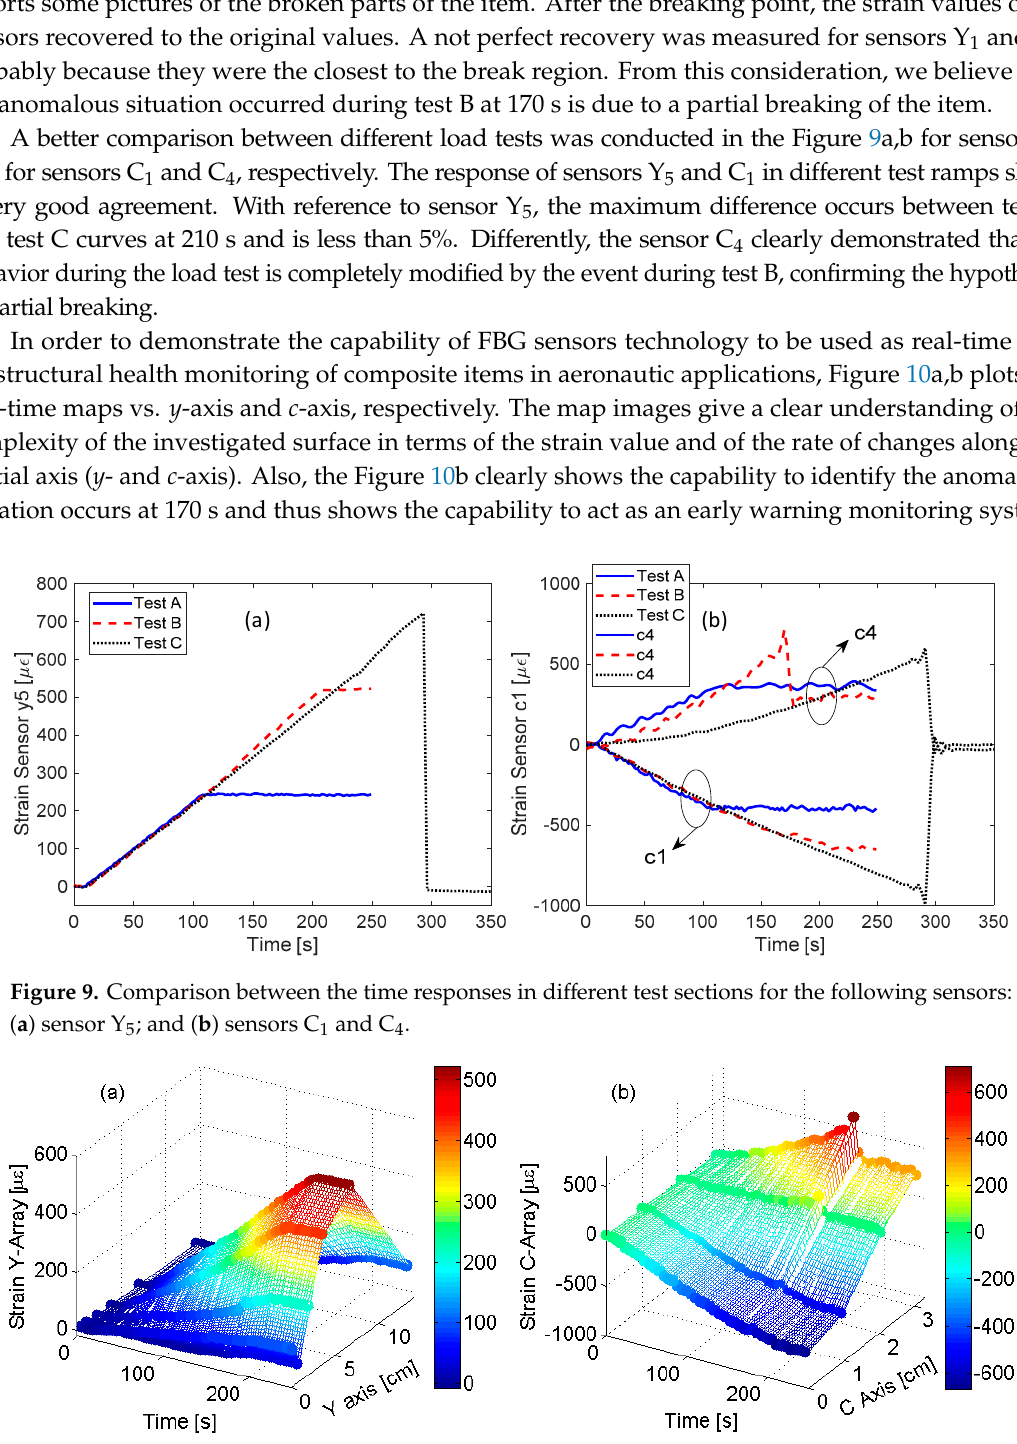
Figure 10. FBG Surface strain profile vs. time: ( a ) strain profile along y -axis; and ( b ) strain profile along c -axis.